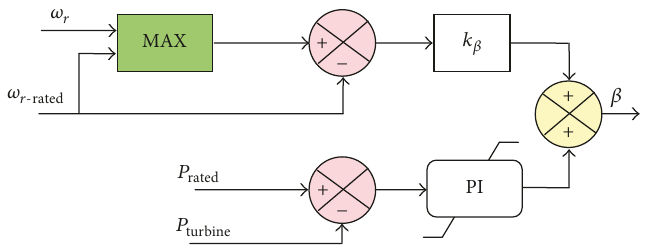
Figure 5: Pitch control diagram for generator speed